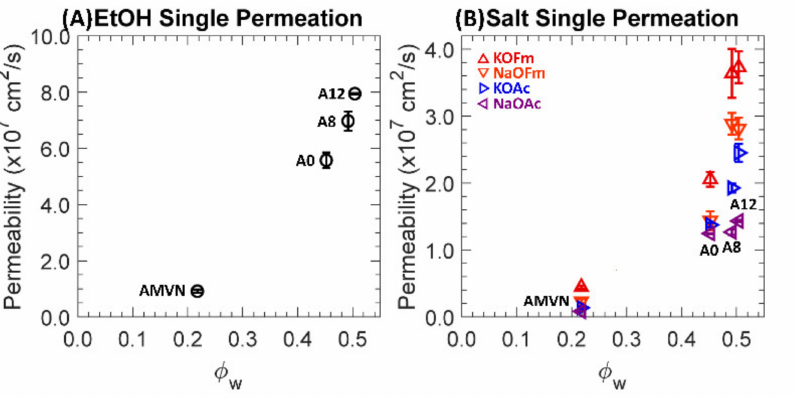
Figure 5. ( A ) Permeabilities to EtOH, , in single permeation. ( B ) Permeabilities to KOFm ( (cid:52) , red), (cid:35) NaOFm ( (cid:53) , orange), KOAc ( (cid:46) , blue) and NaOAc ( (cid:47) , purple) in single permeation. Each data point is the average of 3 experiments, with error bars corresponding to the standard deviation.